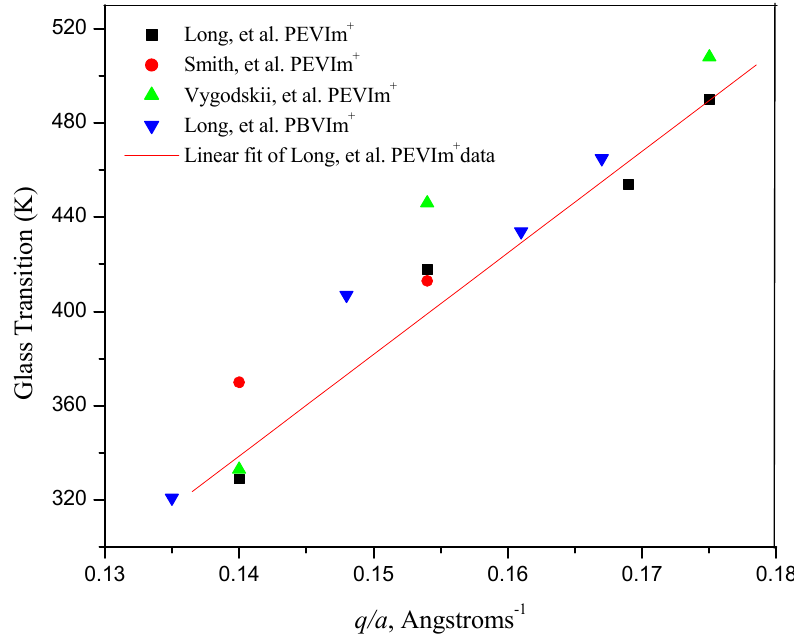
Figure 7. Glass transition temperature (K) versus the ratio of the charge on the ion and the separation between the ion pair, q / a , for poly(3-ethy-1-vinylimidazolium) and poly(3-butyl-1-vinylimidazolium) salts. ( (cid:4) and (cid:78) Long et al. [12]; • Smith et al. [33]; (cid:78) Vygodskii et al. [27]). The molecular volume of PEVIm + is taken to be 0.156 ± 0.018 nm 3 , equal to that re- ported for EMIm + [49]. The molecular volume of PBVIm + is taken to be 0.196 ± 0.0.021 nm 3 , equal to that reported for C4MIm + [49]. Assuming anions and cations to be spherical, ionic radii of the respective ions and respective anions and cation were calculated from the molecular volume of ions [50]. The distance between the anion and the cation, a , was calculated as the sum of the radii of the respective anions and